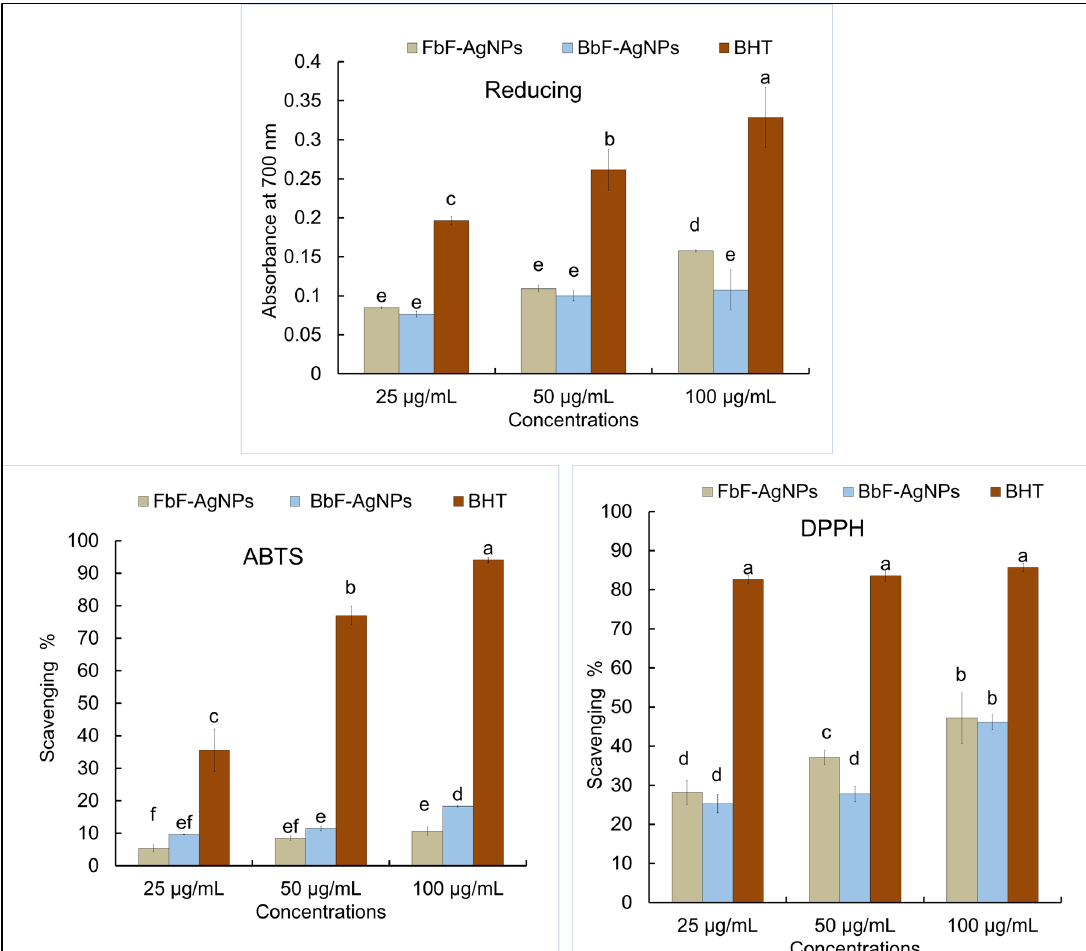
Figure 8. In vitro antioxidant potential (reducing power, ABTS and DPPH assay) of Fbf-AgNPs and Bbf-AgNPs. Differences in superscript letters in each assay indicate statistically significant differences at p < 0.05.